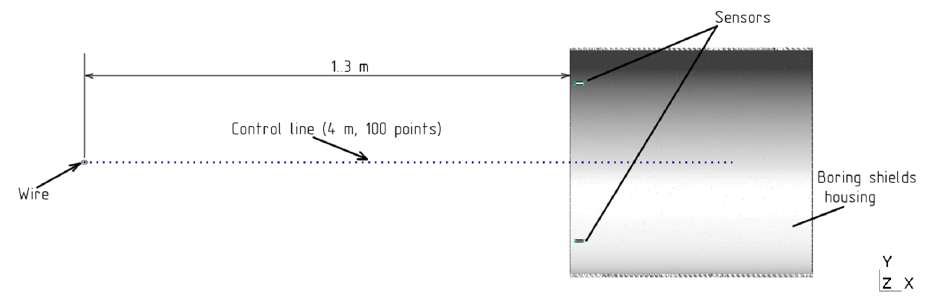
Figure 2. Location of the control line in the computational domain.